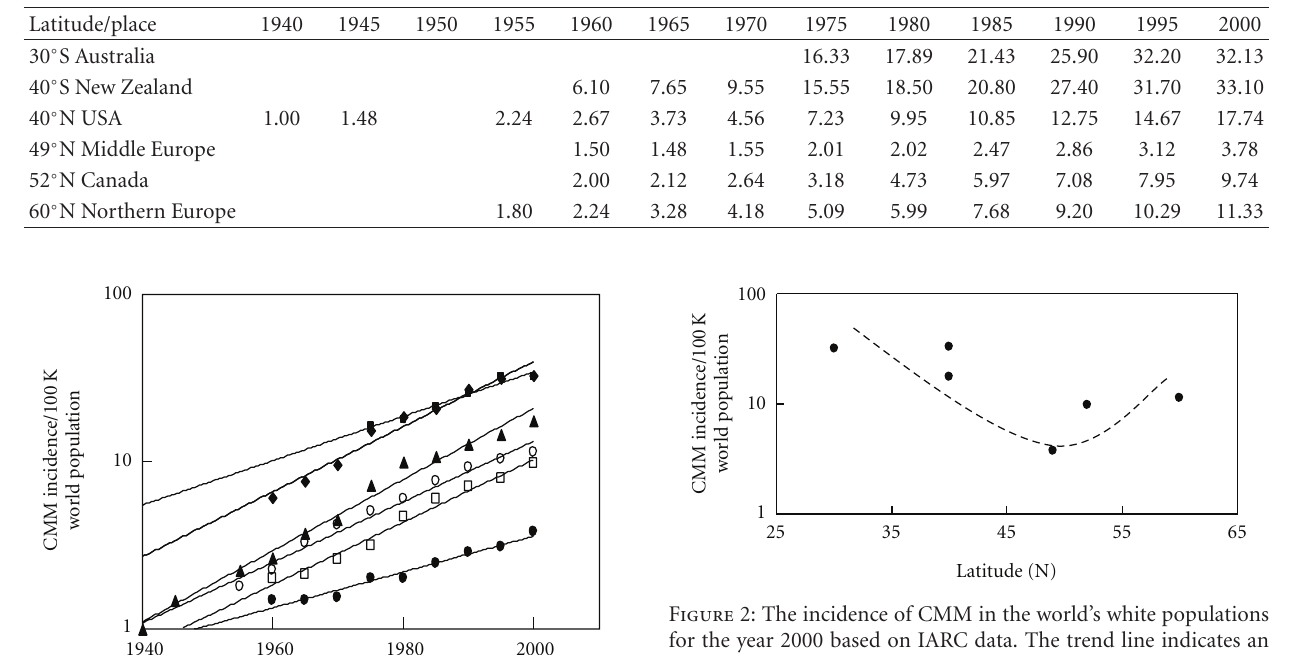
Table 1: Averaged CMM age-adjusted incidences among whites per 100,000 people (world population) in each country of the northern and southern hemispheres (plotted in Figure 1); data is from [3–11] except 1940 [1], 1945, and 1955 [2] for the USA.